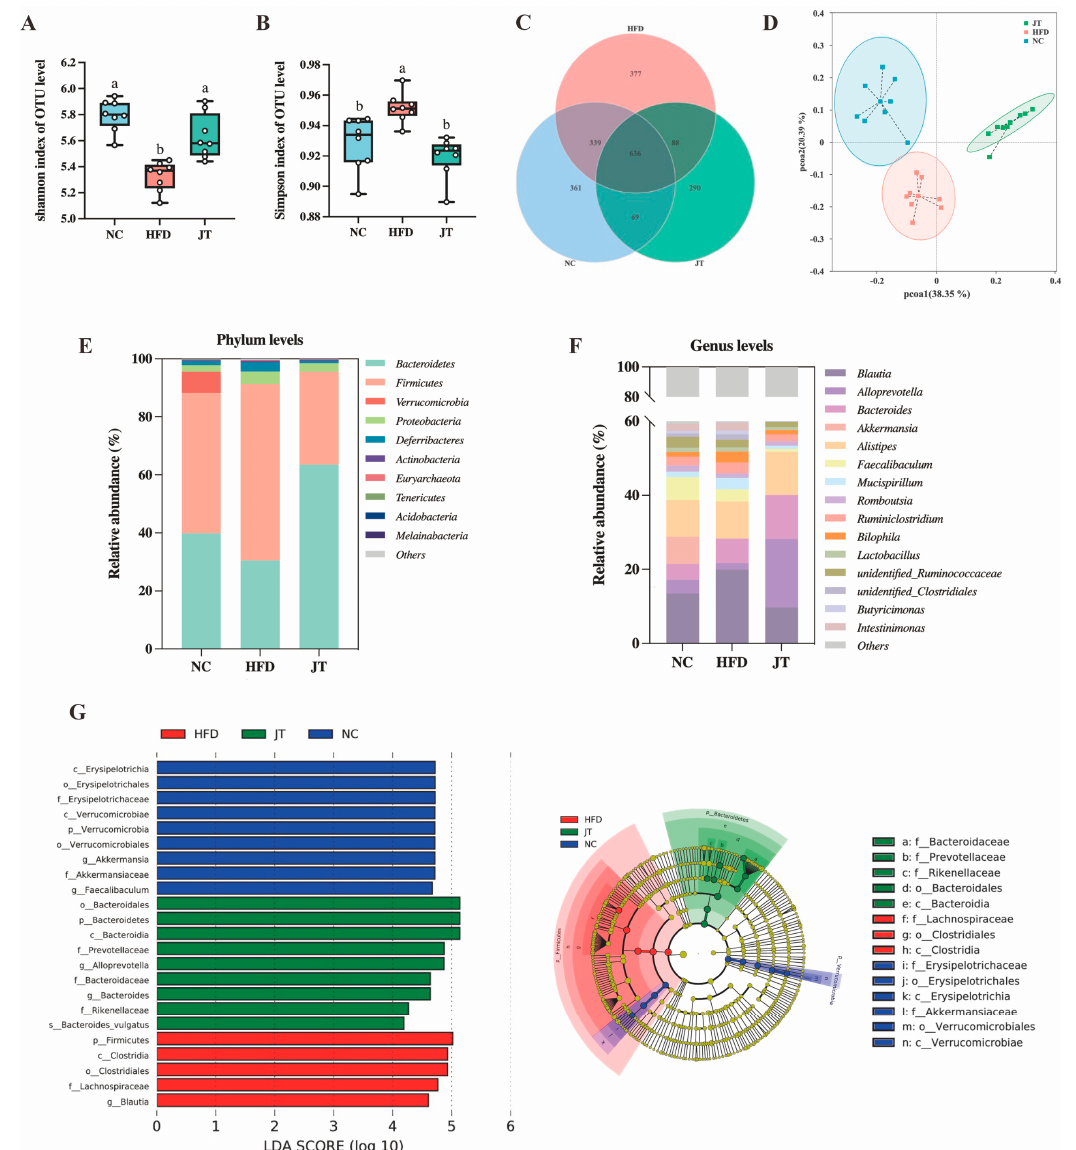
Figure 5. CB-JT modulated HFD-induced gut microbial disorder. ( A ) Shannon index. ( B ) Simpson index. ( C ) Venn diagrams of OTUs in the gut microbiota among groups. ( D ) PCoA. ( E ) Bacterial taxonomic composition at the phylum level. ( F ) Bacterial taxonomic composition at the genus level ( G ) LEfSe analysis (LDA score > 4). NC: normal-chow group, HFD: high-fat diet group, JT: jasmine tea group. Data are expressed as the mean ± SEM. The mean value with different letters indicates significant differences ( p < 0.05).